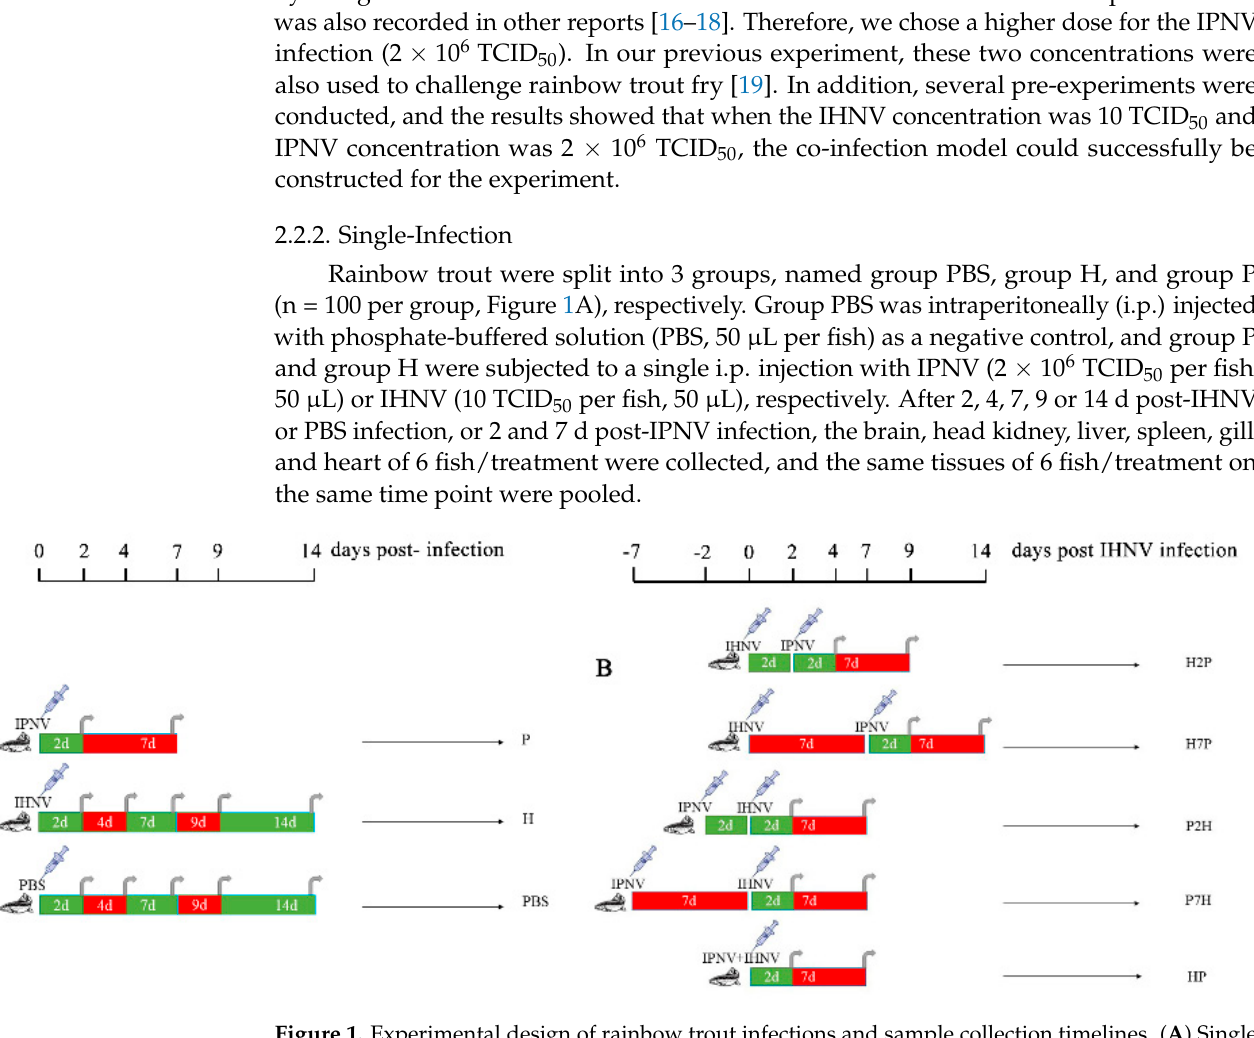
Figure 1. Experimental design of rainbow trout infections and sample collection timelines. ( A ) Single infection; ( B ) co-infection. H, single IHNV infection; P, single IPNV infection; HP, i.p. infection of IHNV and IPNV simultaneously; P7H, i.p. infection of IPNV 7 d prior to IHNV i.p. infection; P2H, i.p. infection of IPNV 2 d prior to IHNV i.p. infection; H2P, i.p. infection of IPNV 2 d after IHNV i.p. infection; H7P, i.p. infection of IPNV 7 d after IHNV i.p. infection; PBS, single PBS infec- tion.